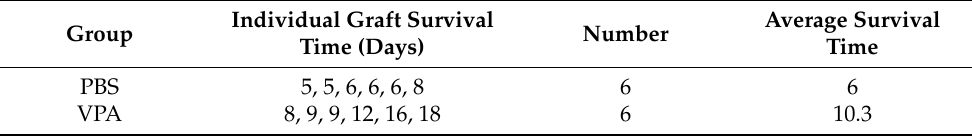
Table 3. The survival time of islet grafts in PBS- or VPA-treated cell transferred NOD recipients.